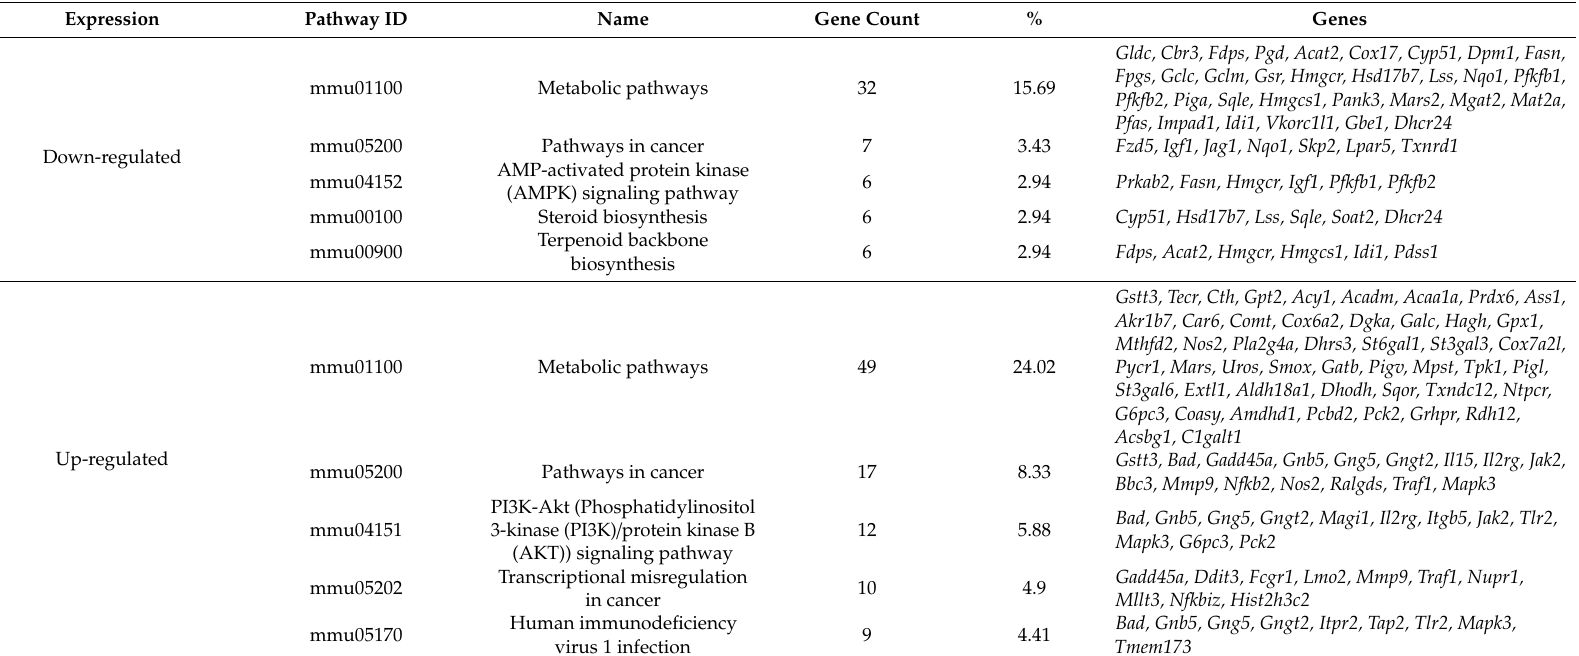
Table 2. Kyoto Encyclopedia of Genes and Genomes pathway (KEGG) pathway analysis of up-regulated and down-regulated DEGs. Expression